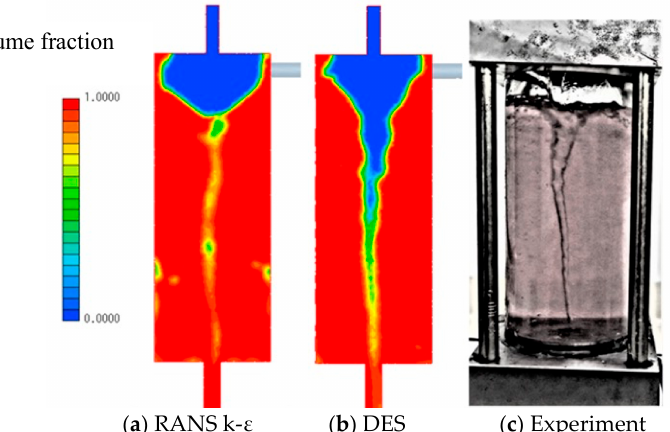
Figure 4. Comparison of volume fraction of fluid.